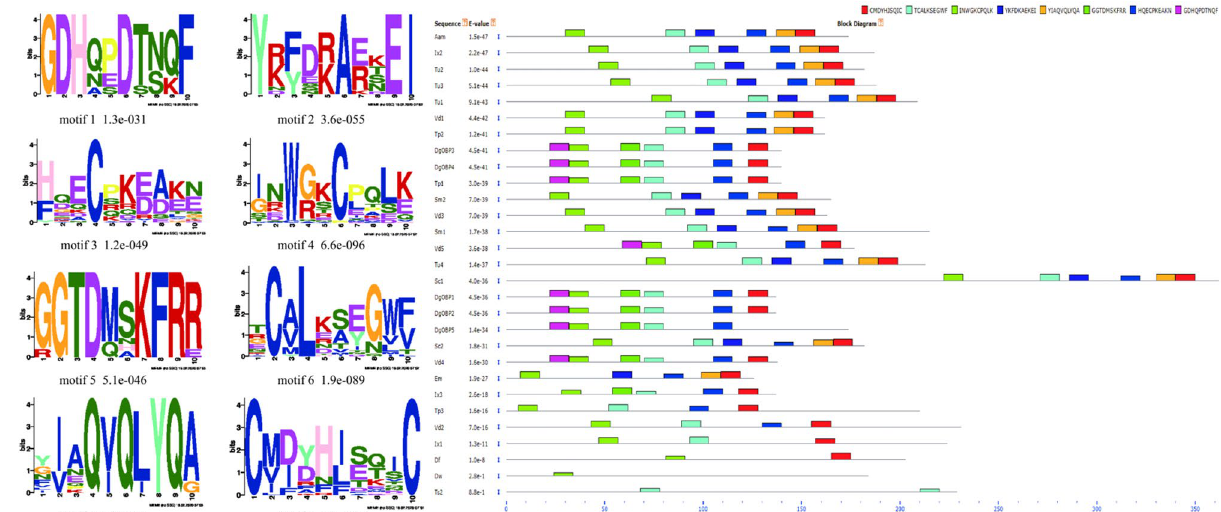
Figure 6. Motif-pattern analysis of OBP protein from D. gallinae and other classes including insecta and arachnida. The parameters setting in this study for motif predictions were: minimum width of motif = 6, maximum width = 10 and maximum number of motifs to find = 8. Motif-based sequence analyses were predicted by using web-based version 5.1.0 of the MEME server. Eight amino acid motifs with various widths and corresponding e-values were identified, and the lower part indicates approximate locations of each motif on the protein sequence. Different motifs are shown by different colored boxes, where small number indicate high